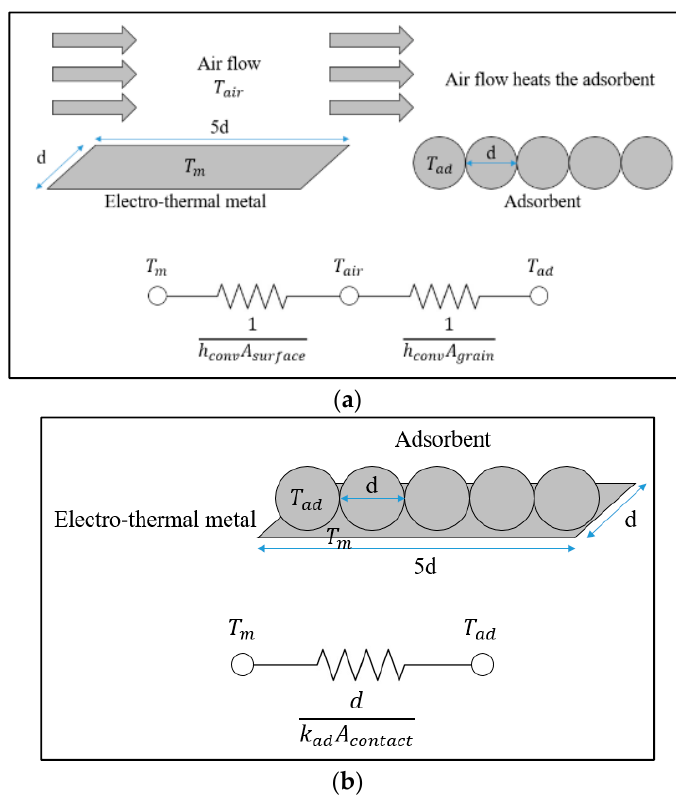
Figure 5. Comparison of ( a ) indirect and ( b ) direct heating systems.